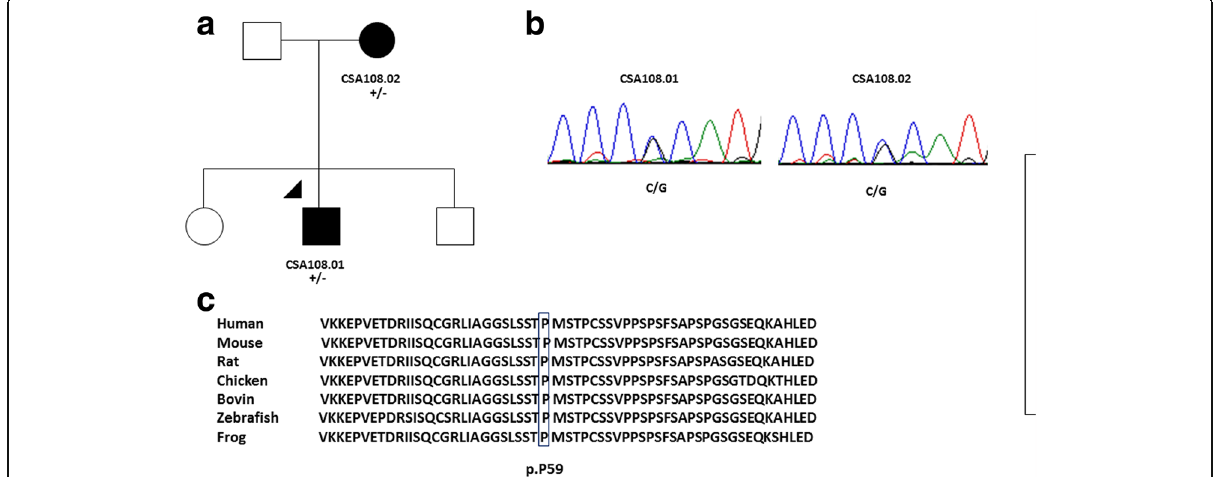
Fig. 1 a Pedigree of family CSA108 with variant in MAF . Individuals with ID numbers were examined by an ophthalmologist. Solid circles indicate affected females and solid squares indicate affected males. The proband is marked by an arrow head . “ + ” indicates mutant allele and “ − ” indicates wild type allele of c.176C > G in the MAF gene. b Sequence chromatogram of two examined individuals at variant c.176C > G. Both sequenced affected members are heterozygous for this variant. c Protein alignment shows the MAF protein is highly conserved among the indicated species. The mutated residue is indicated by the